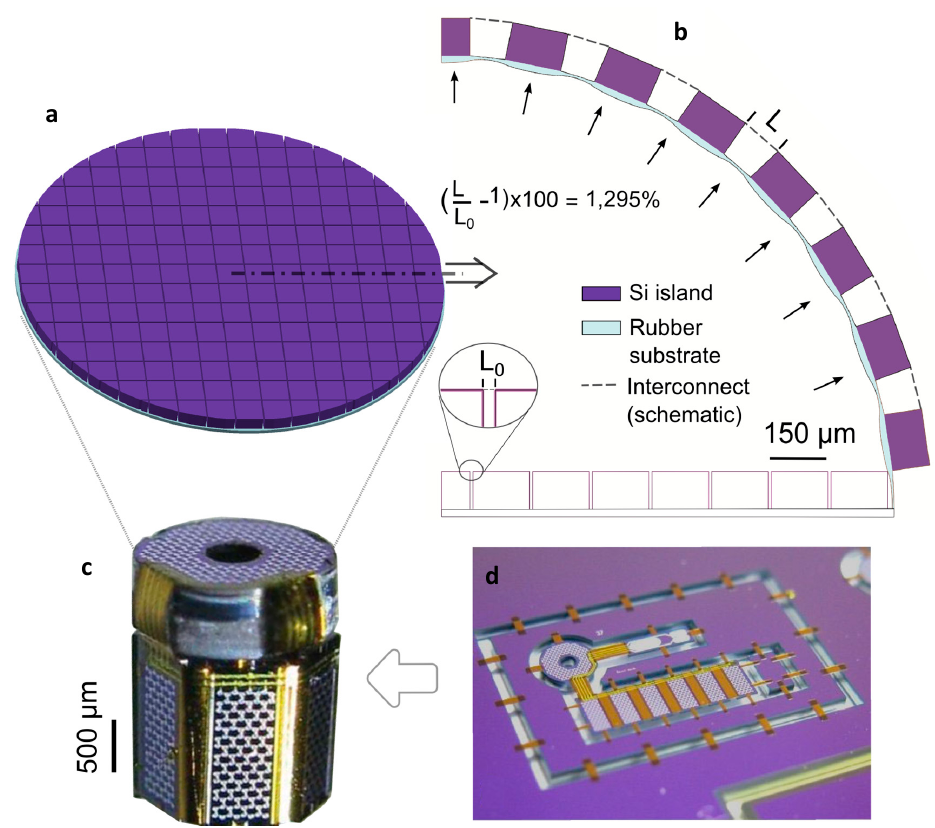
Figure 1. Concept illustration of an inflatable catheter-tip ultrasound detector with highly stretchable interconnects ( a , b ), versus the current state-of-the-art technology in miniature flexible devices: the capacitive micromachined ultrasound transducer (CMUT) array on a catheter tip produced using